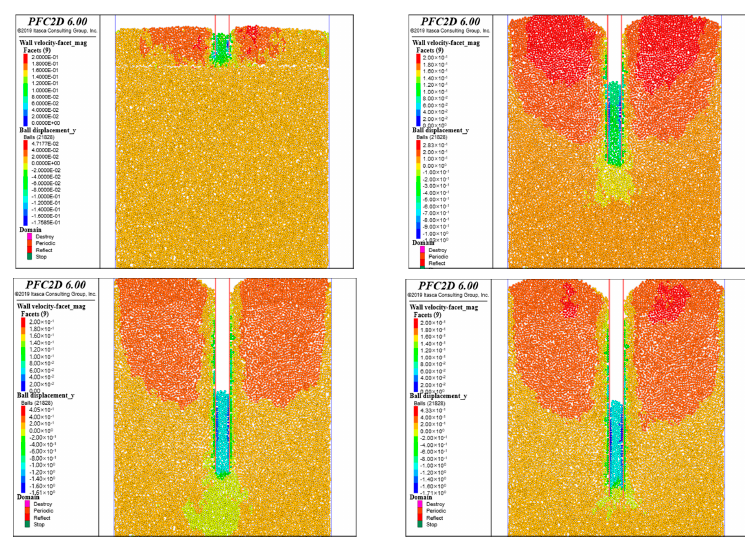
Figure 8. Simulation results of condition b .